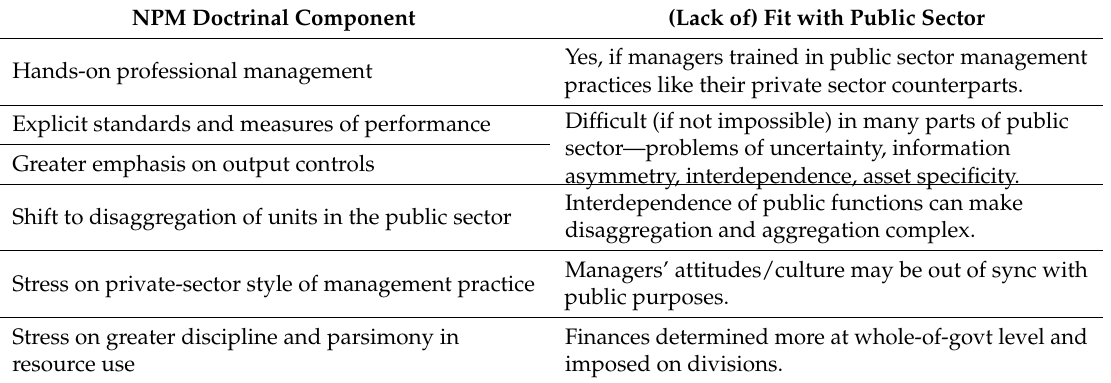
Table 2. NPM compared with public